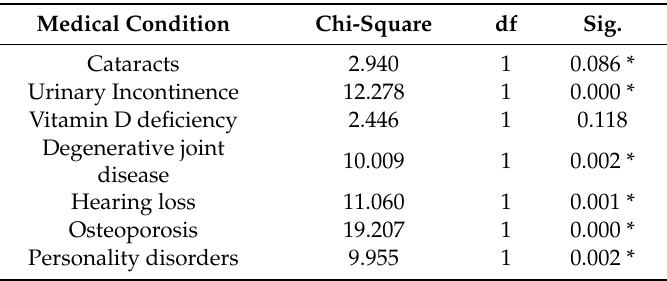
Figure 3. Osteoporosis’ disease and gender. This figure shows the percentage of men and women who have osteoporosis, di ff erentiated into the two groups under study. Table 2 indicates the Pearson’s Chi-square values and significance levels for the comorbidities shown in Table 1. Table 2. Chi-square data and significance values for cataracts, urinary incontinence, vitamin D deficiency, osteoarthritis, hypoacusis, osteoporosis, and personality